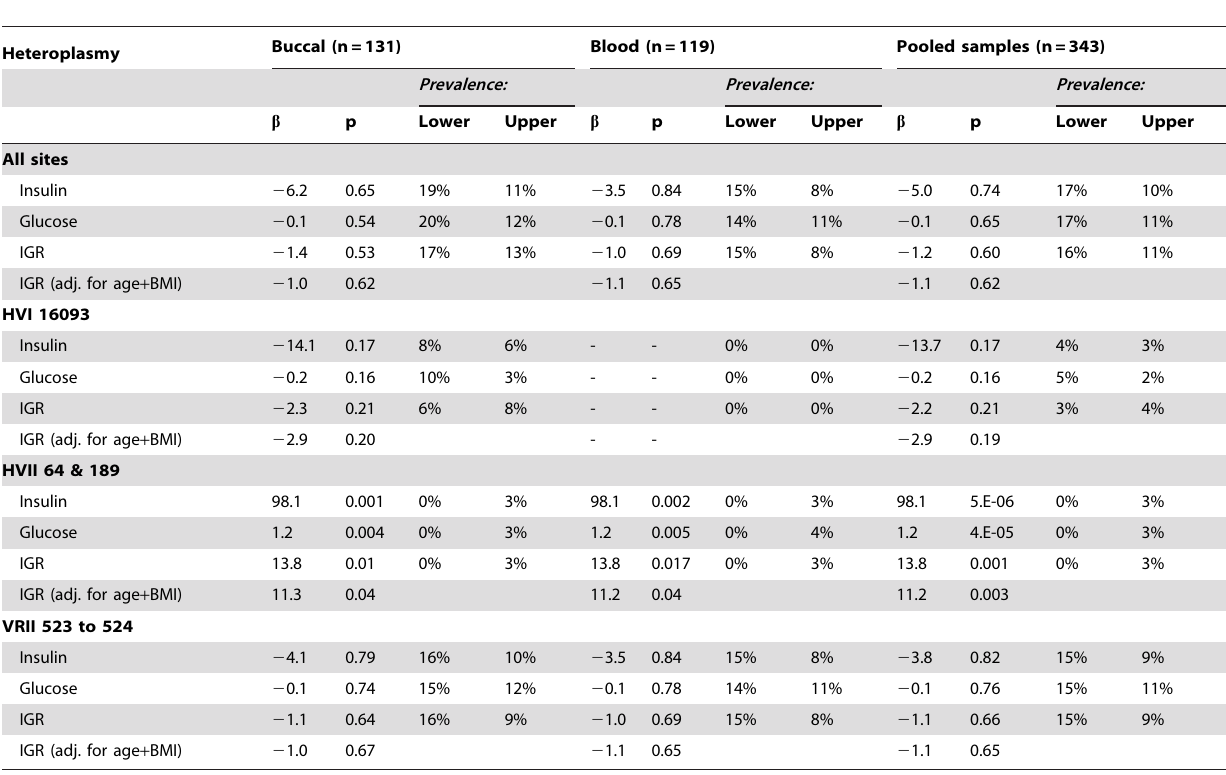
Table 4. Heteroplasmic association with insulin (pmol/l) and glucose (mmol/l) fasting serum levels.